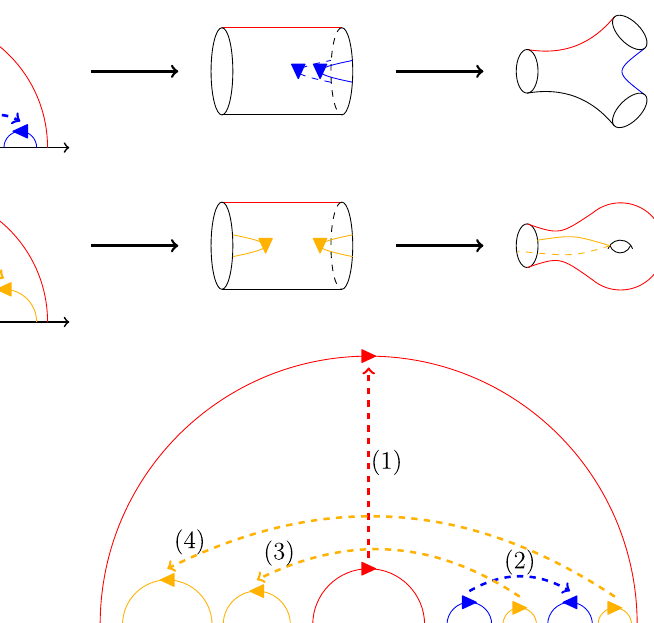
Fig. 14 The fundamental domain of the ( 1 , 2 ) Riemann surface.